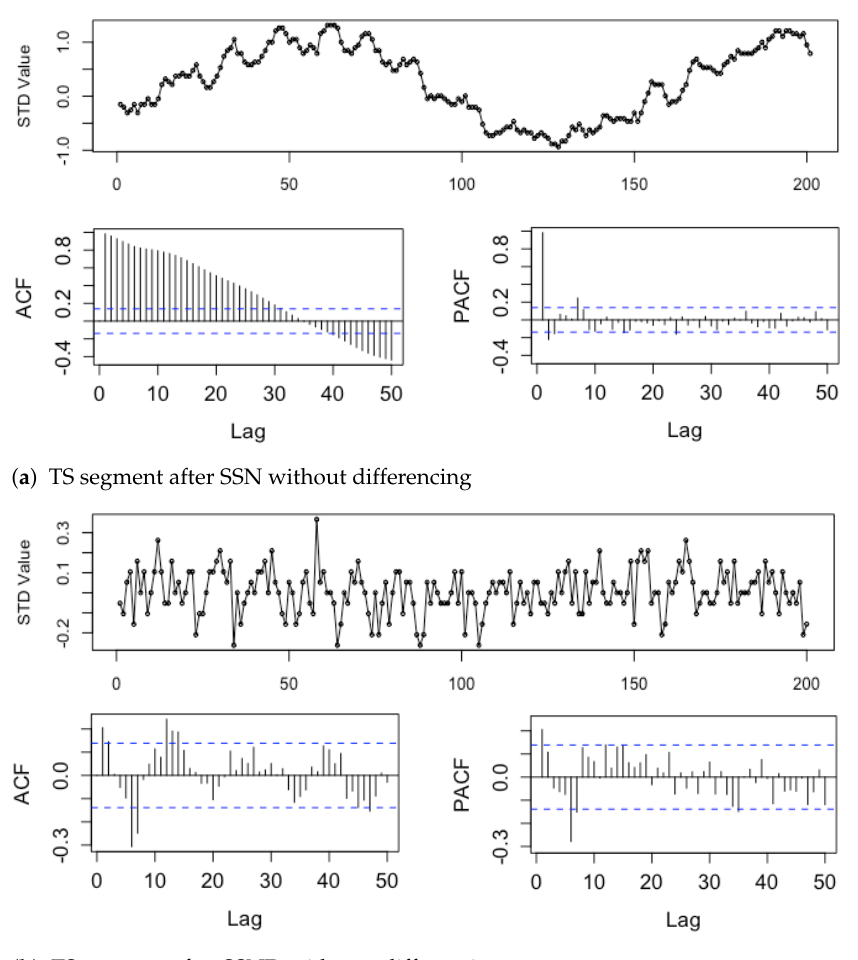
Figure 8. Standardized (STD) value, ACF, and PACF of one sample TS segment with different pre- processing. (Dashed lines: approximate 95% confidence intervals of the white noise results; vertical lines: values beyond which autocorrelations are (statistically) significantly different from zero